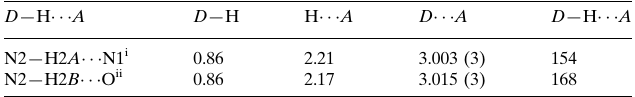
Hydrogen-bond geometry (A˚ , (cid:1)